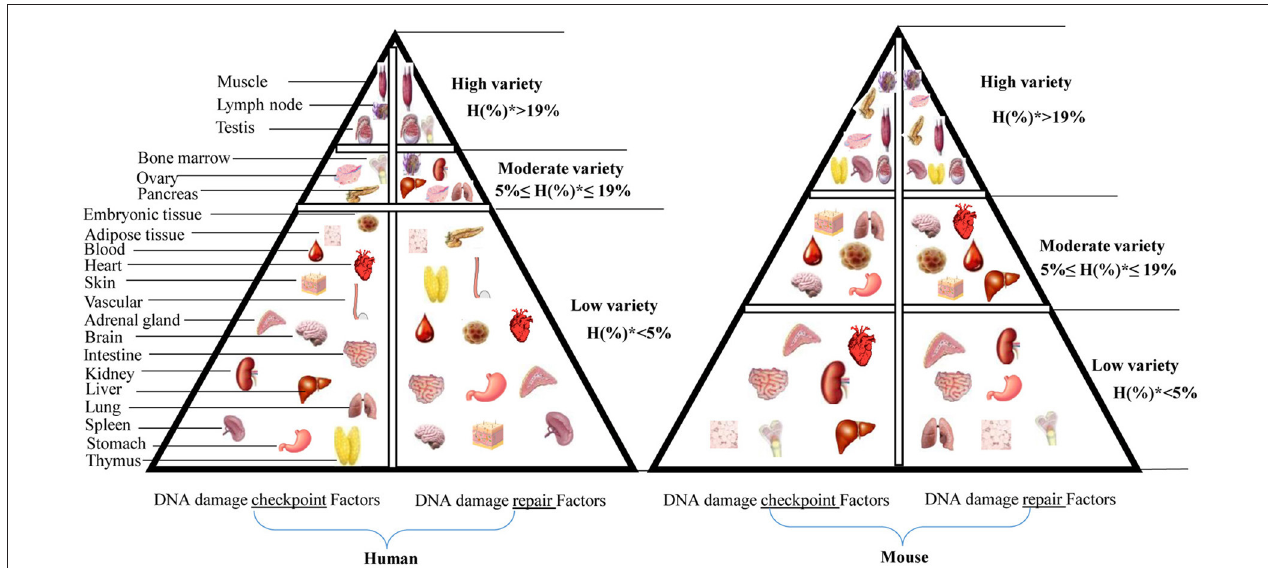
FIGURE 4 | Newly proposed “DNA damage checkpoint and repair factors” model in humans and mice. This tissue pyramid model suggests that DNA damage response factors are differentially regulated in tissues. Further, abundance of DDCFs co-relate with the level of expression of DDRFs. H(%)* = number of genes with high expression in each tissue/ number of DDCFS or